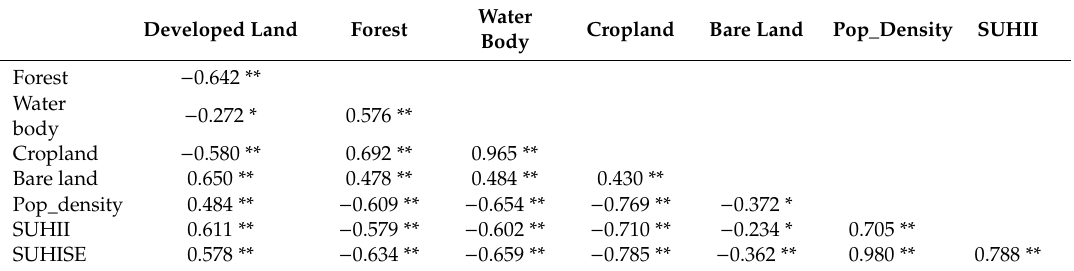
Table A1. Correlation matrix indicating the multicollinearity between the